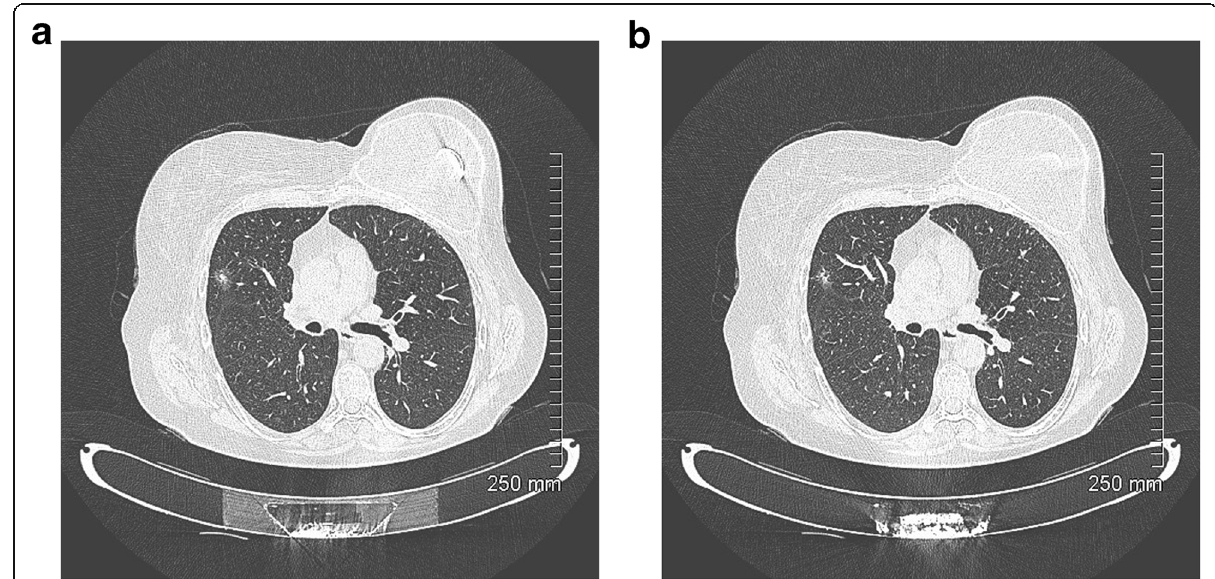
Fig. 18 a , b Unfavourable prognostic indicators: focal pleural/fissural retraction. Part-solid nodule in the right upper lobe. Lepidic predominant adenocarcinoma